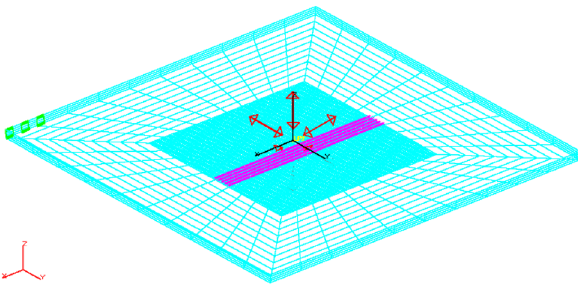
Figure 9. The numerical BEM model built in the SAES software package.